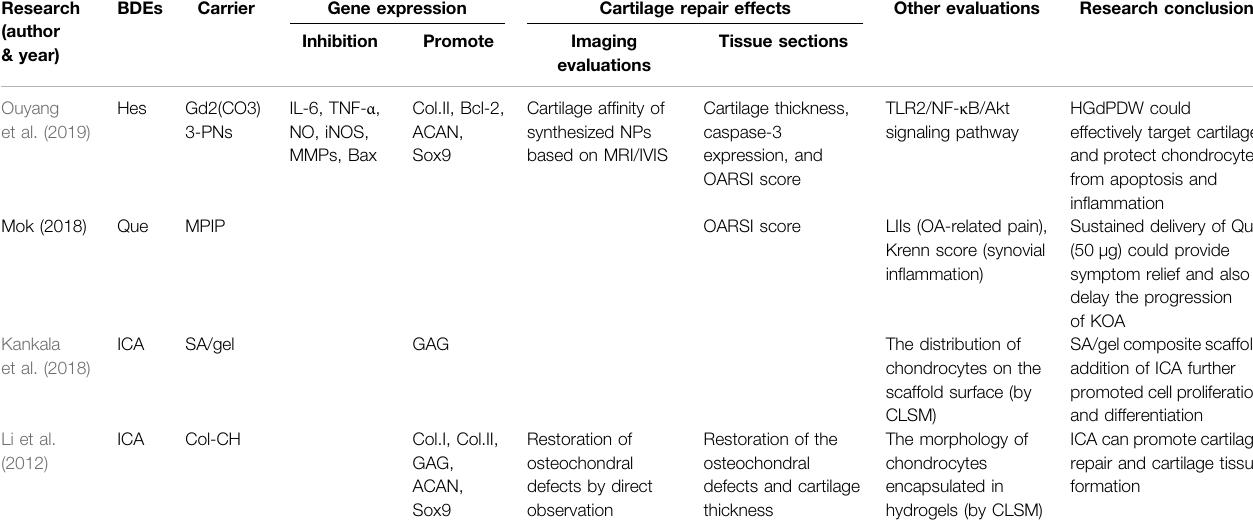
TABLE 1 | The effect of fl avonoids combined with carriers on OA cartilage